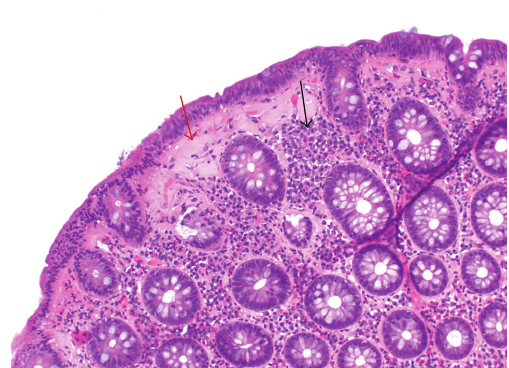
Figure 2: Show prominent thickening of the submucosal collagen table. The submucosal collagen is dense and paucicellular with several entrapped lymphocytes and capillaries (red arrow). The lamina propria display an increase in eosinophils, plasma cells, and lymphocytes (black